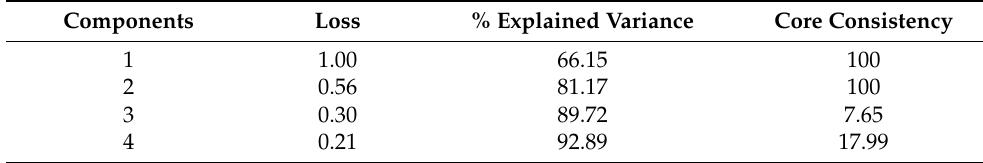
Table 4. Loss function values relative to the value for a one-component model, explained variance (expressed as percentage), and core consistency with respect to the number of components calculated by the PARAFAC